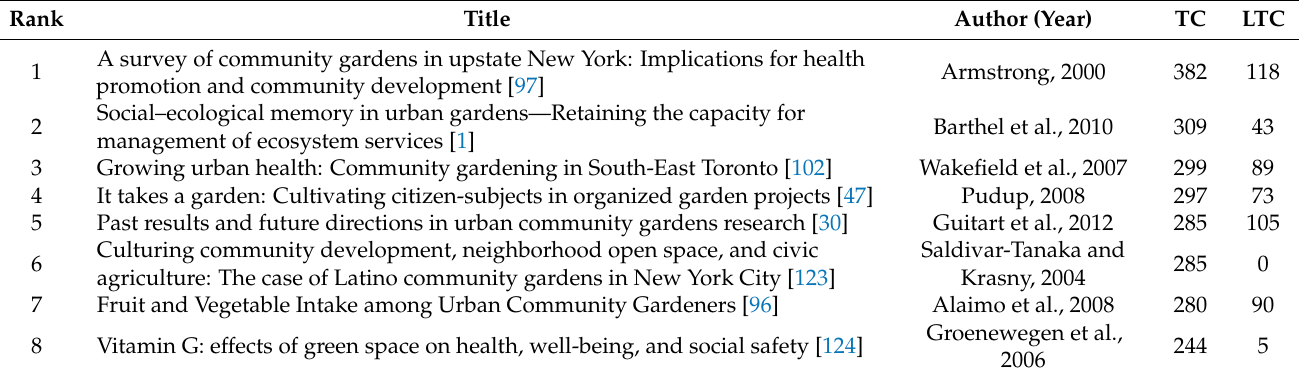
Table 6. The top 20 most cited published papers on community gardens based on global total citations (TC) from 1995 to